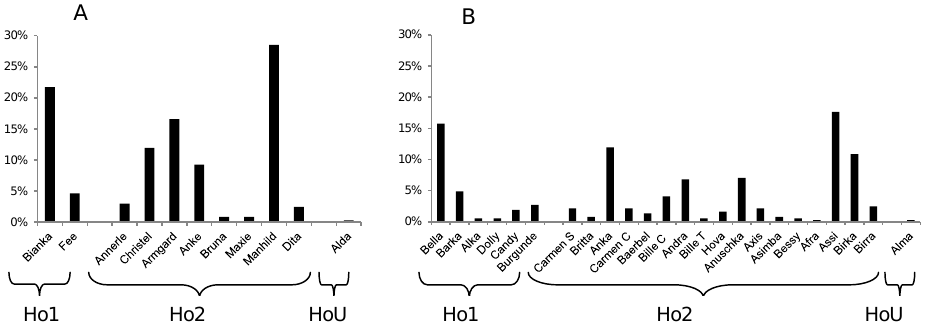
Figure 4. Maximum frequencies of pedigree errors or potential mtDNA point mutations (EMs) in the modern population, assuming that a source of EMs was the female ancestors in the 5th (a) or 10th (b) generation of the